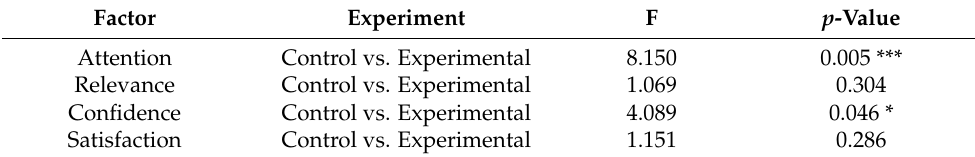
Table 6. ANOVA univariate test results by each factor of IMMS survey test. Factor Experiment F p -Value Attention Control vs. Experimental 8.150 0.005 *** Relevance Control vs. Experimental 1.069 0.304 Confidence Control vs. Experimental 4.089 0.046 * Satisfaction Control vs. Experimental 1.151 0.286 * p -value < 0.05, *** p -value <